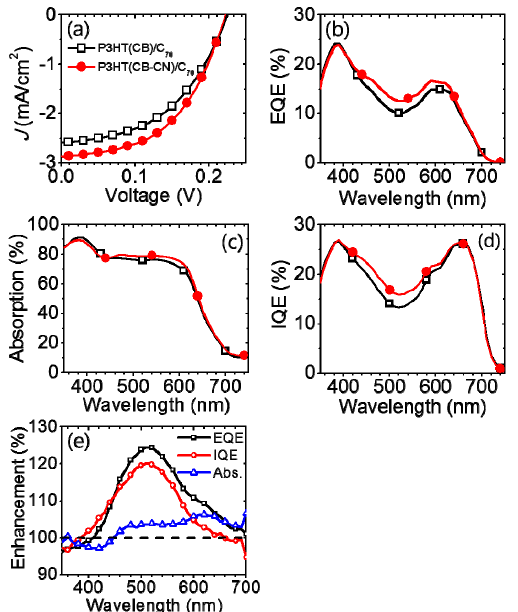
Figure 4. ( a ) Current density ( J ) vs. voltage ( V ) curves; ( b ) EQE spectra; ( c ) absorption intensity; and ( d ) IQE spectra of P3HT(CB)/C 70 bilayer (black open square) and P3HT(CB-CN)/C 70 bilayer OPVs (red solid circle); and ( e ) relative enhancement of absorption intensity and IQE values of P3HT(CB-CN)/C 70 bilayer OPVs compared to those of P3HT(CN)/C 70 .